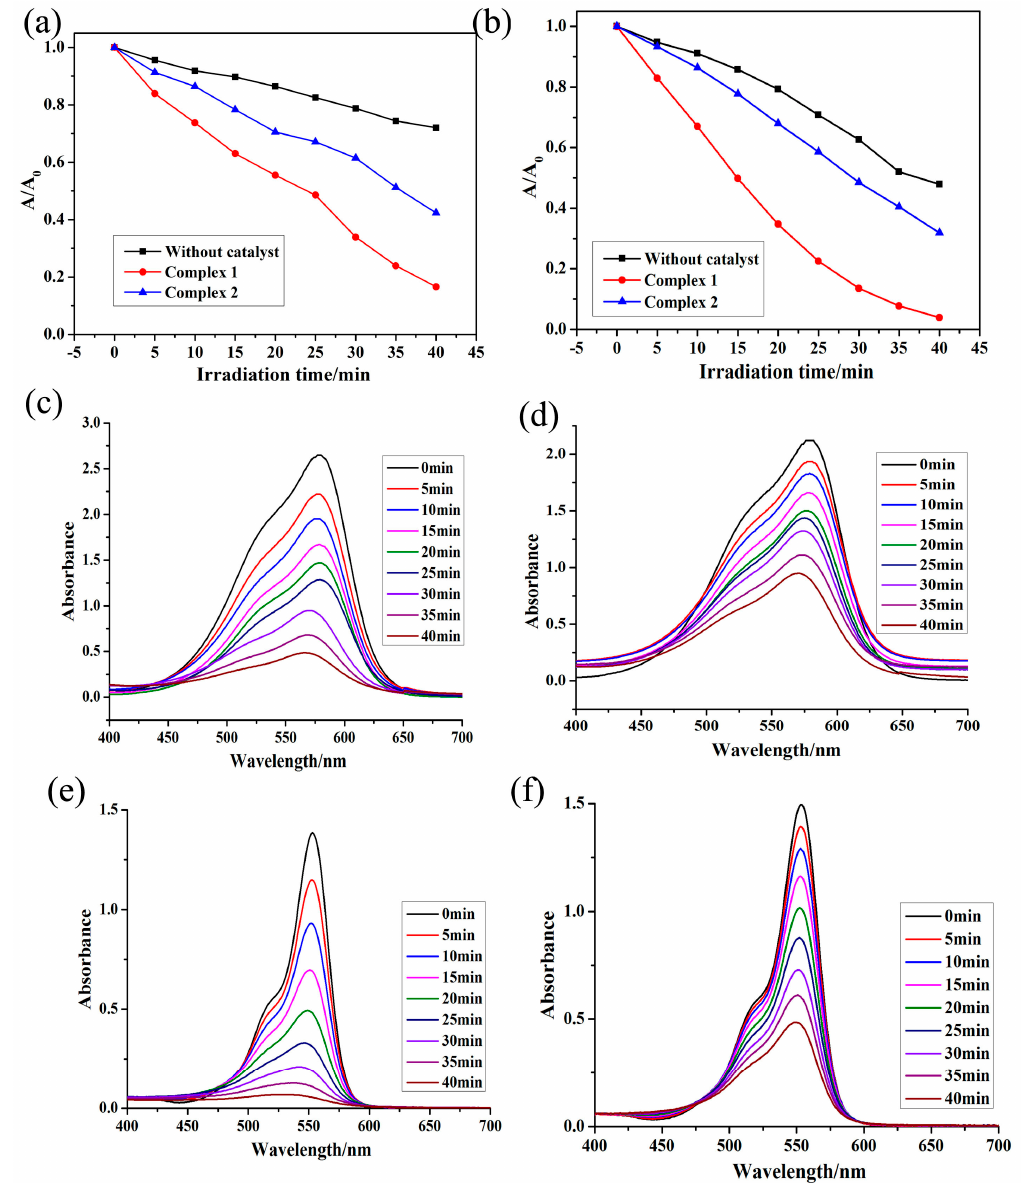
Figure 4. ( a , b ) The plot displaying photocatalytic degradation kinetics of MV and RhB in presence of CPs 1 and 2 ; and ( c – f ) UV–vis absorption spectra of the MV and RhB solution during the decomposition reaction under 250 W Hg lamp irradiation in the presence of CPs 1 and 2 , respectively.